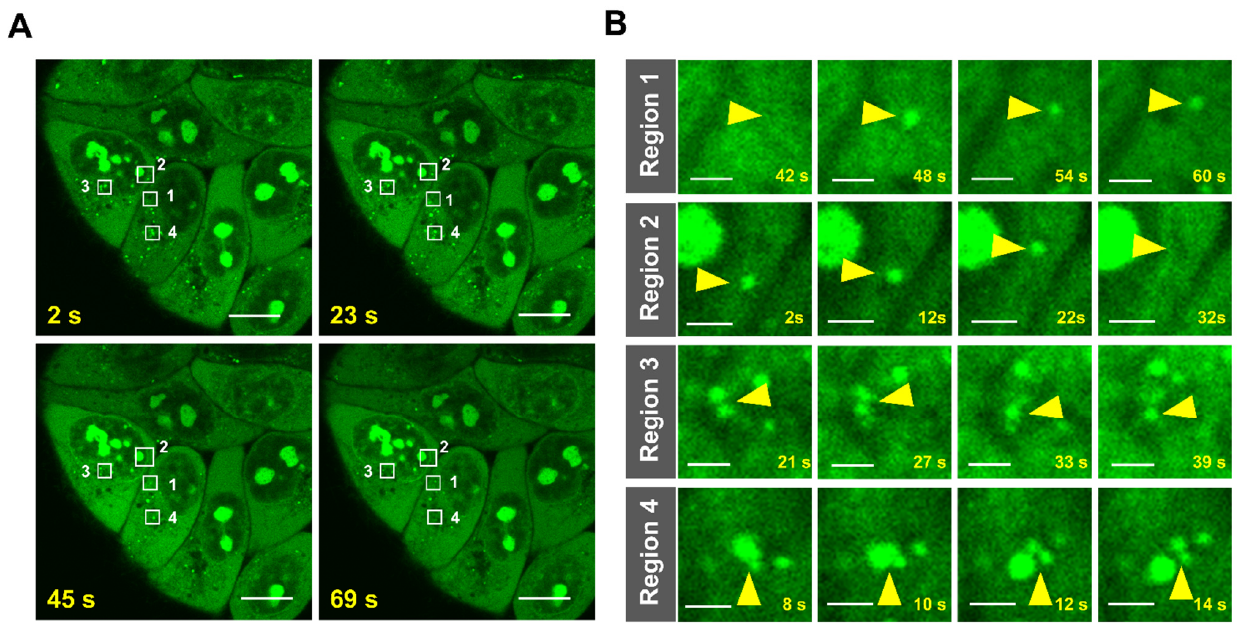
Figure 7. Imaging of live HeLa cells treated without or with sodium arsenite (500 μ M) and stained with QUID − 2 (0.5 μ M, λ ex = 488 nm, λ em = 500–600 nm, green). Scale bars for cell image: 10 μ m. 3. Conclusions In summary, we have successfully developed a highly selective and sensitive fluo- rescent probe called QUID − 2 for RNA imaging through the structural modification of precursor probe QUID − 1 . The detection limit of QUID − 2 for the RNA was up to 1.8 ng/mL in solution. This value was significantly improved in comparison with its parent QUID − 1 , which had a detection limit of 26.5 ng/mL. We further demonstrated many advantages of QUID − 2 over a commercially available RNA staining probe, SYTO RNASelect, for selec- tive and sensitive RNA sensing by a systematic comparison of fluorescent properties for RNA. Moreover, QUID − 2 possesses excellent photostability and low cytotoxicity in live cells, which is beneficial for long-term cell imaging. Thanks to many advantages of